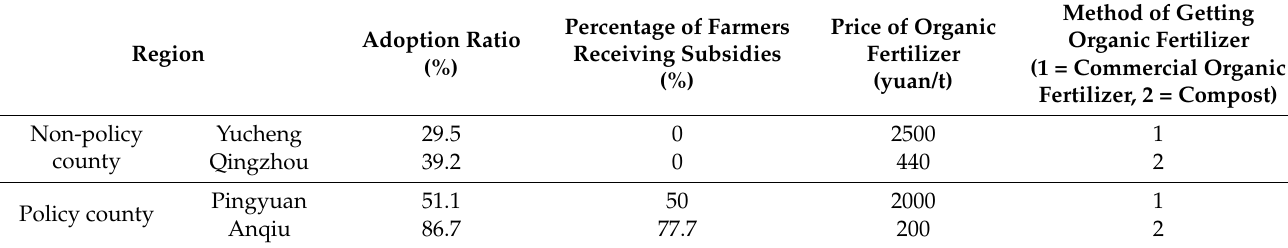
Table 6. Investigated counties and vegetable farm household